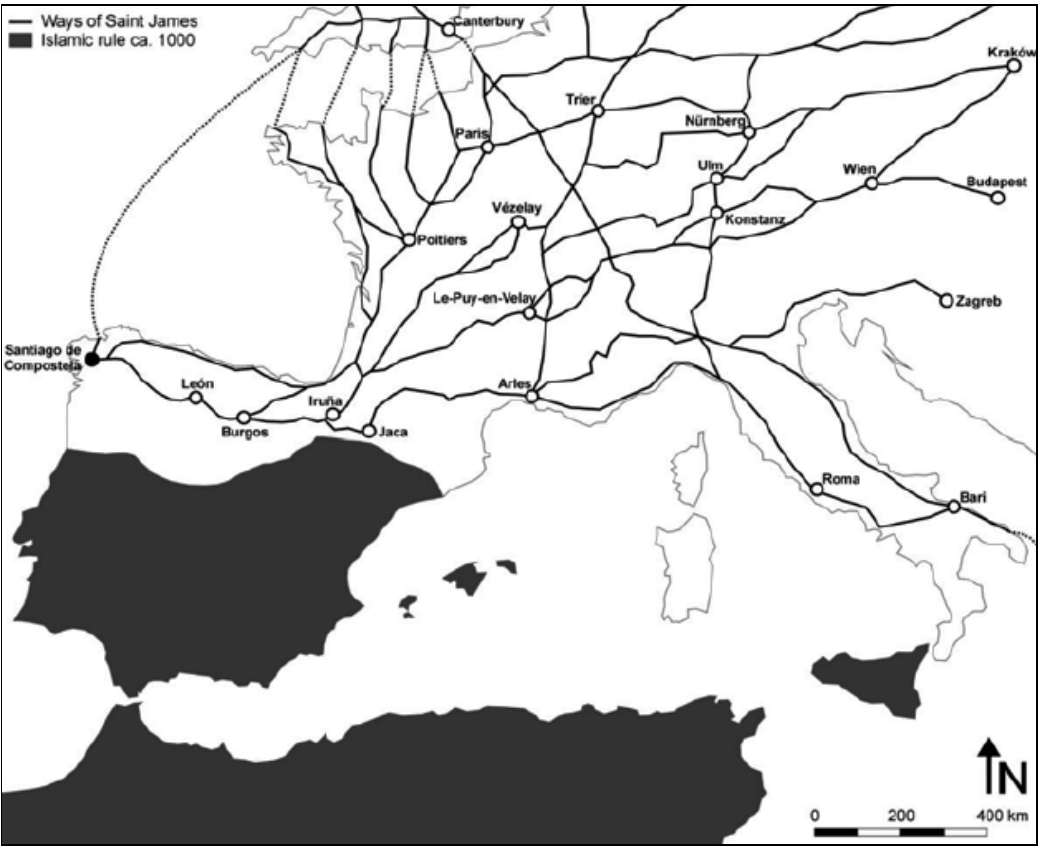
Figure 1. The Ways of St. James in the High Middle Ages (map by ValeriàPaül, in Lois González et al. 2015, p. 714).